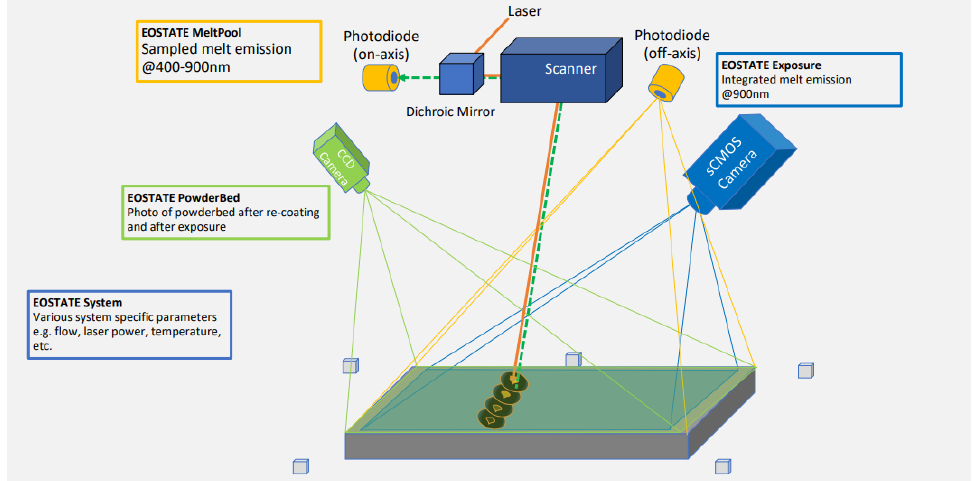
Figure 3. An overview of EOSTATE monitoring